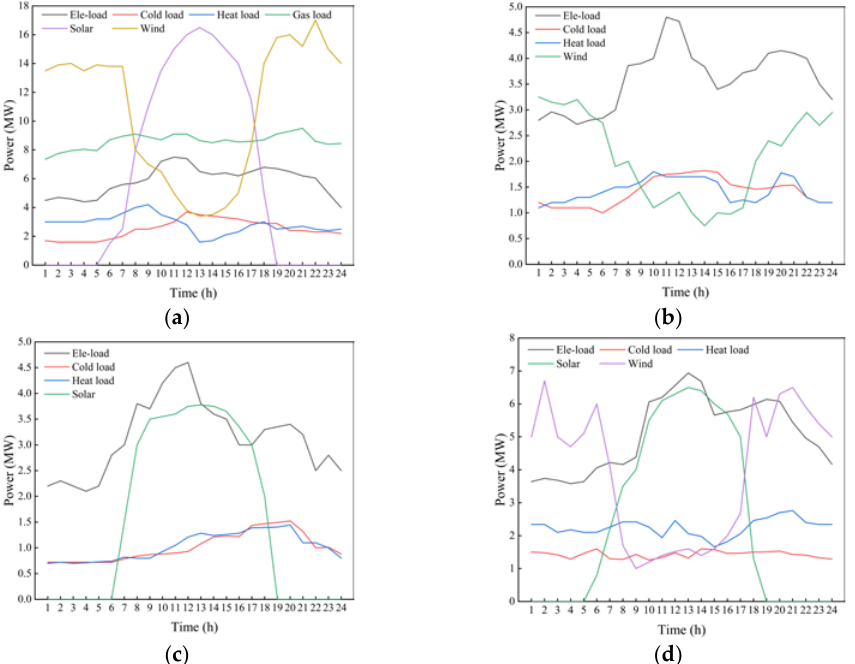
Figure A1. Structure configuration of each PIES: ( a ) PIES 1 structure configuration; ( b ) PIES 2 structure configuration; ( c ) PIES 3 structure configuration; ( d ) PIES 4 structure configuration.